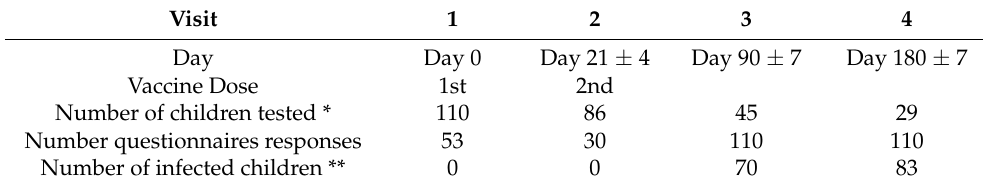
Table 1. Study follow-up schedule and visit